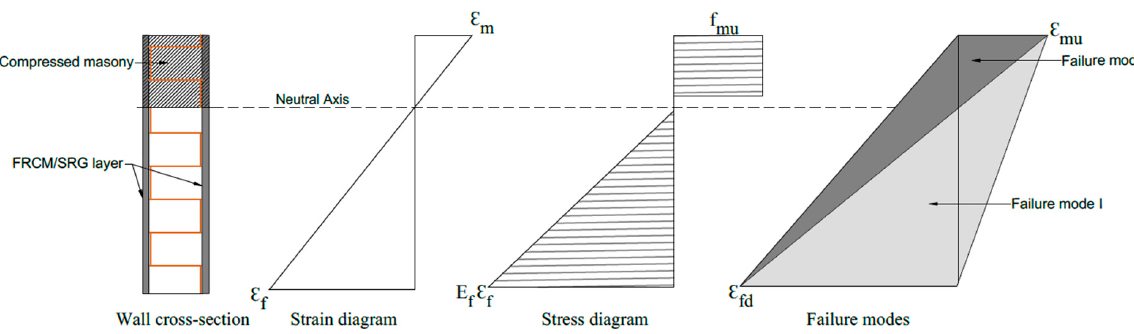
Figure 8. Cross-section of the wall, strain, stress profiles, and failure modes.